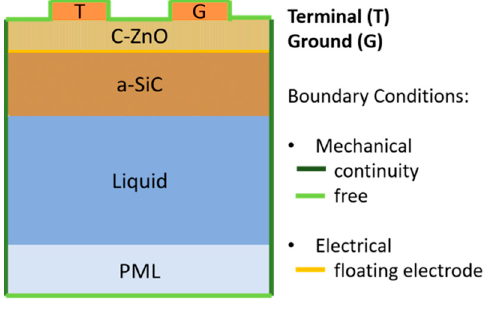
Figure 6. The FEM schematic.